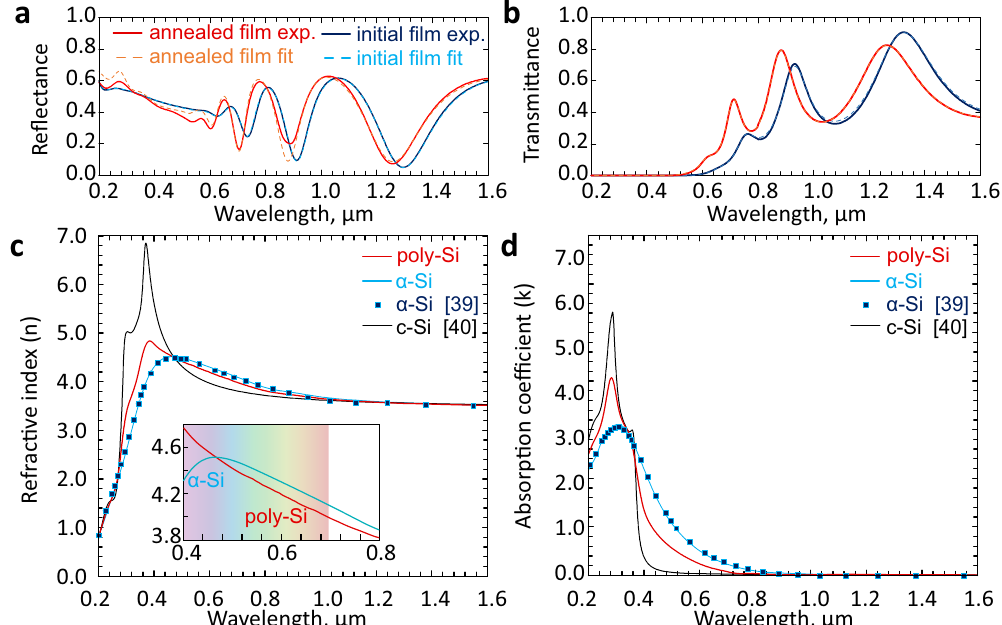
Figure 3. ( a , b ) Measured and calculated reflection and transmission spectra of pristine α -Si and laser-annealed poly-Si films. Solid curves provide experimental data while dashed curves present numerical fit. ( c , d ) Refractive index ( n ) and absorption coefficient ( k ) of pristine α -Si (blue solid curve) and laser-annealed (red solid curve) poly-Si film calculated from experimentally measured optical spectra. Inset in (c) highlights difference in refractive index of pristine and laser-annealed films in the visible spectral range. Markers in (c,d) give reference data for amorphous Si ( α -Si, [52] ) and monocrystalline Si (c-Si, black curve, [53]